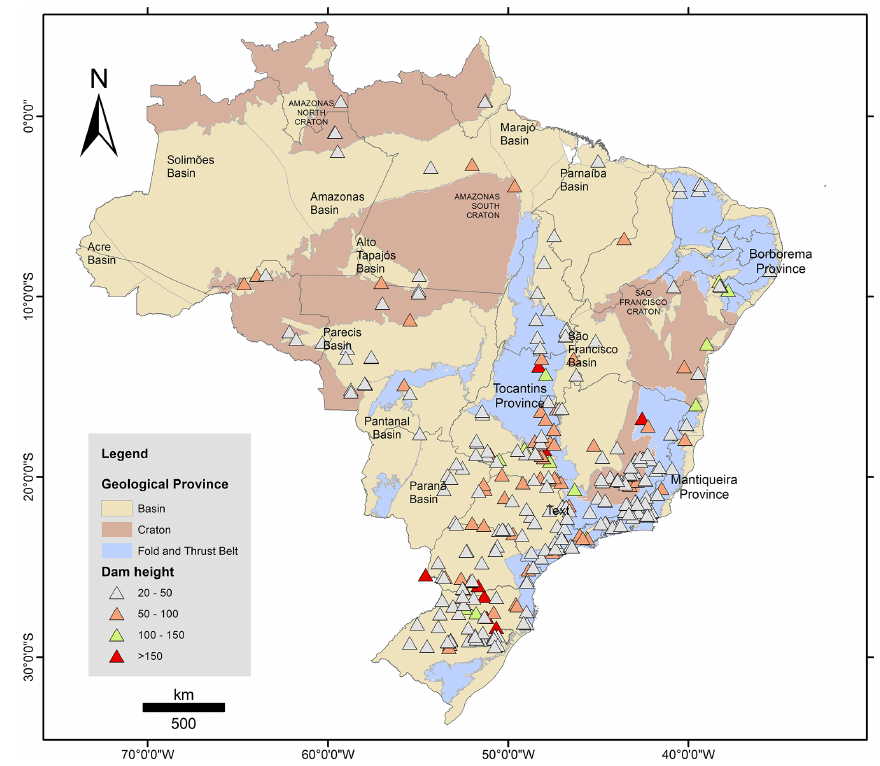
Figure 10. Map of Brazil with 348 dams with a height of 20m or more (data from the Brazilian Committee on Dams, 2018). The colors refer to the main geological provinces (data from CPRM – Mineral Resources Research